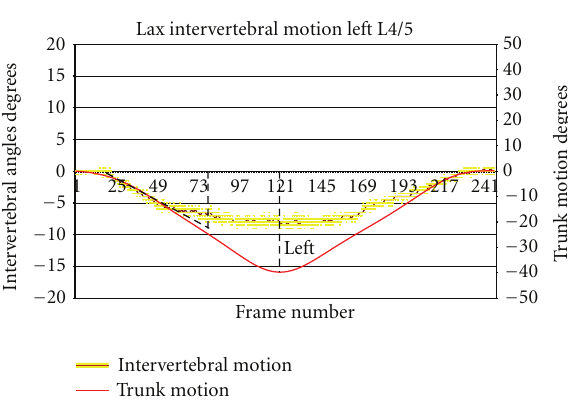
Figure 6: Example of use of intervertebral versus trunk motion graphs for the calculation of laxity by ratio of their slopes in the first 10 degrees of global motion (slope of global motion = −